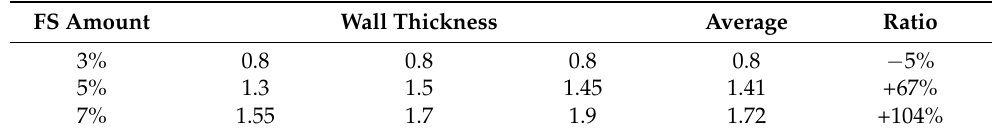
Table 3. Wall thickness of successfully printed cube.